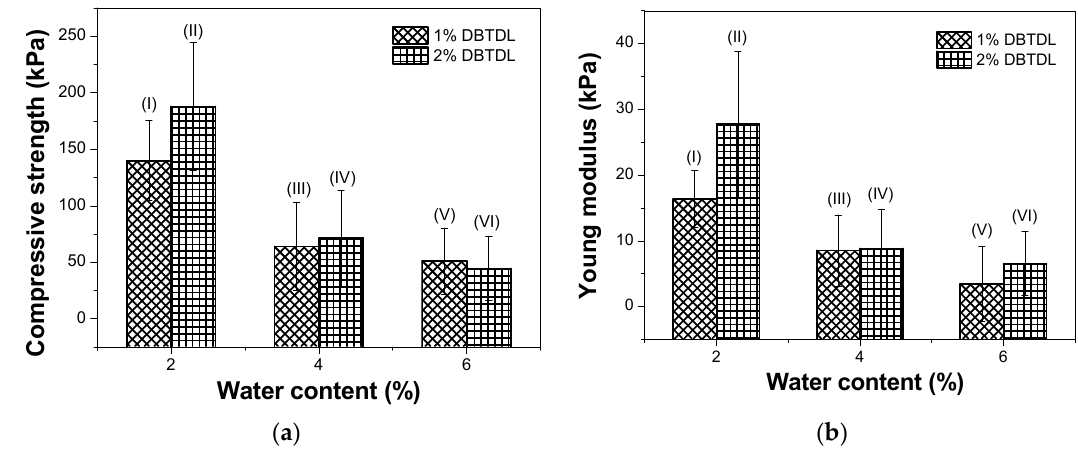
Figure 8. ( a ) Compressive strength and ( b ) Young’s modulus of foams with different contents of blowing agent (water) and catalyst (DBTDL). The numbers corresponding to the foam formulations (Table 1) are indicated in each point of these